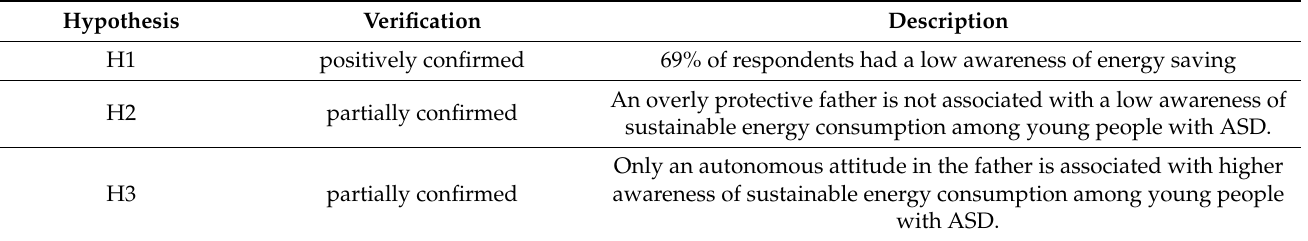
Table 4. Results of hypothesis